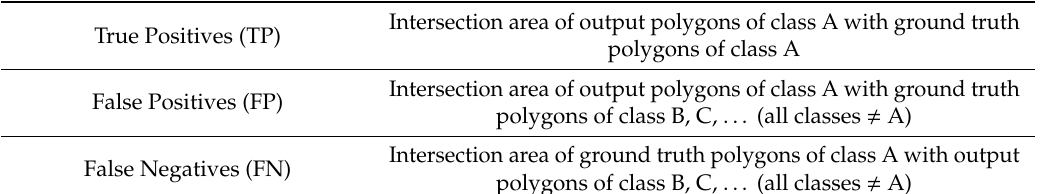
Table 2. Counts for area-based evaluation.